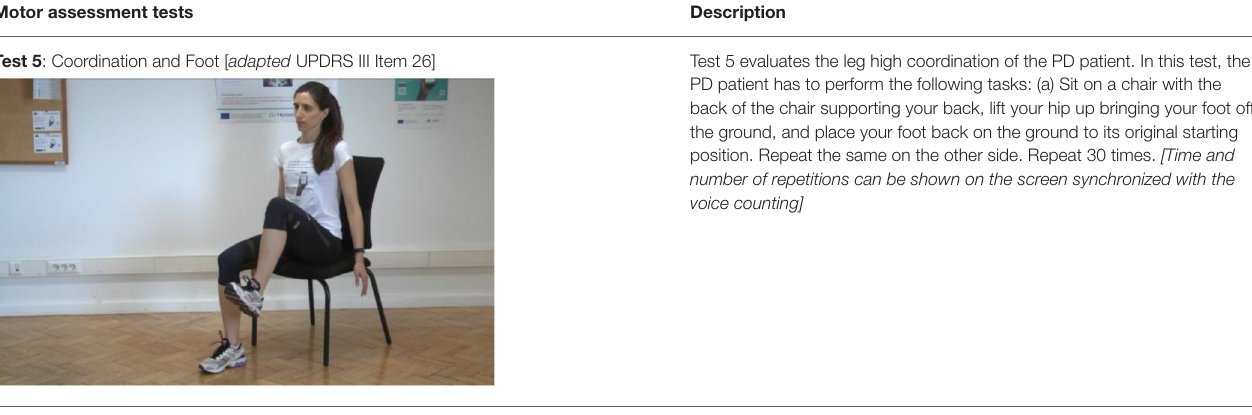
Motor assessment tests